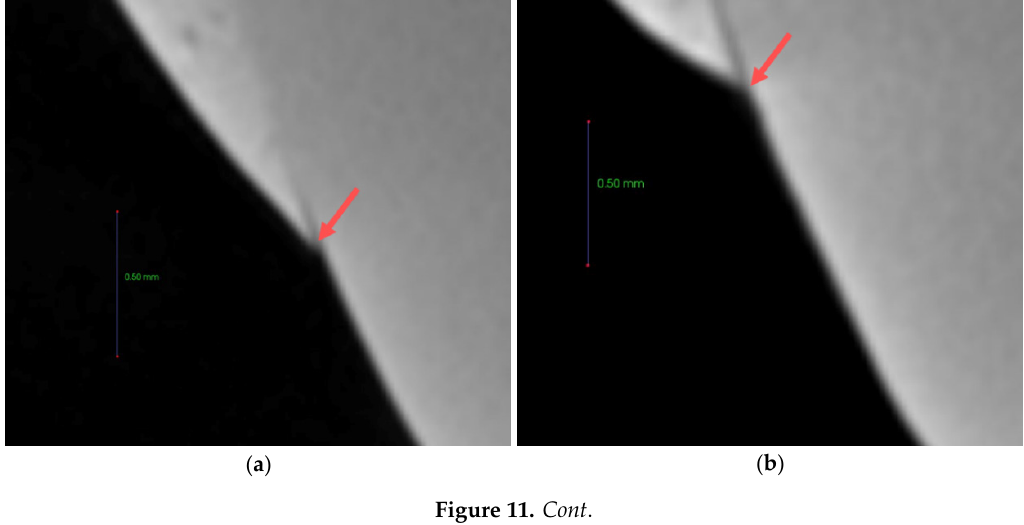
Figure 10. Anti-demineralization length comparison of orthodontic bonding adhesive containing LV and FBAG using ImageJ analysis. The Kruskal-Wallis test was used to compare the shear bond strength within groups (p < 0.05). Mann-Whitney test was used to analyse the difference of means between groups. Error bars represent ± standard error.